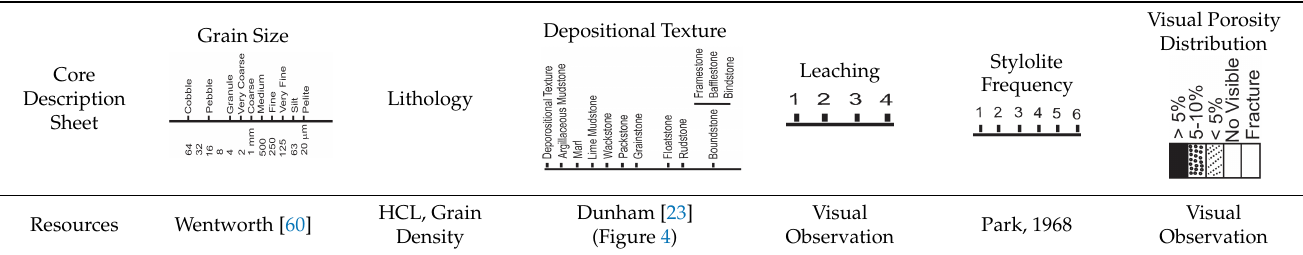
Table 4. Flow of core description for this study.